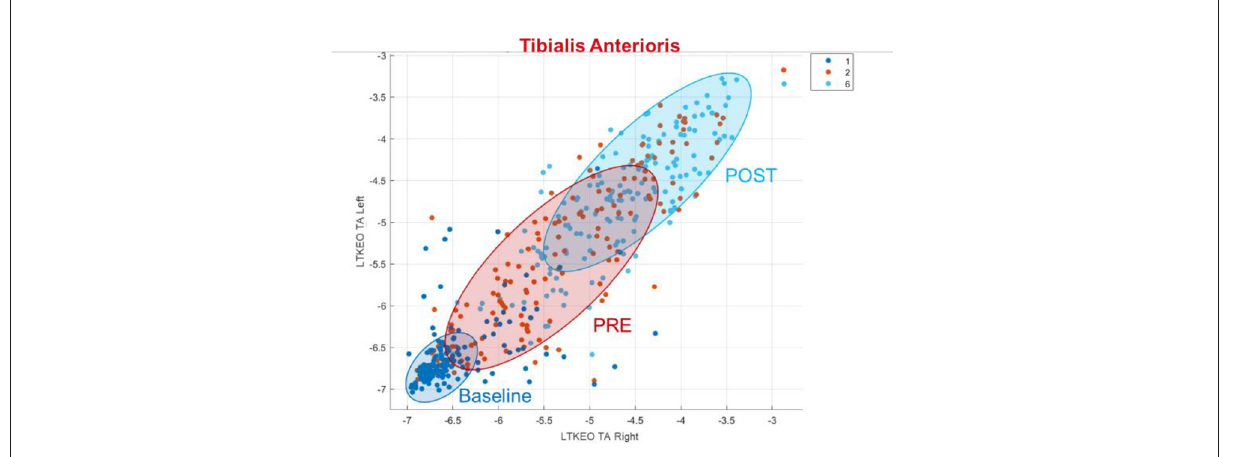
FIGURE5 LTKEO feature for tibialis anterioris. LTKEO, Logarithmic Teager-Kaiser energy